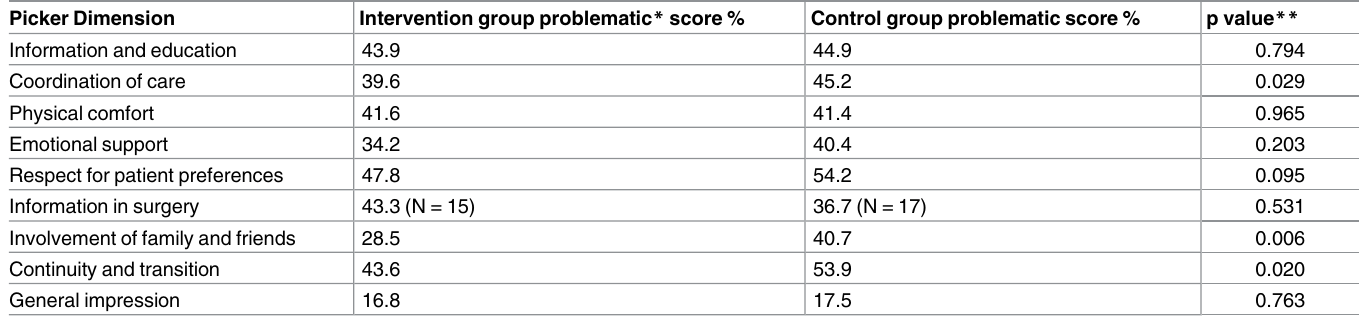
Table 2. Main dimensions of patient satisfaction as measuredby the Picker questionnaire for the two groups (N = 90 unless otherwise stated). Picker Dimension